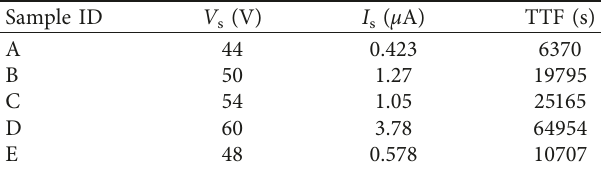
Table 2: Saturation voltages ( V failed samples.